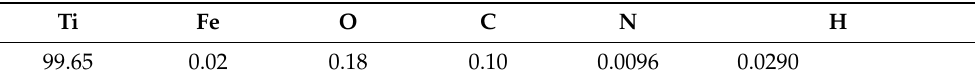
Table 1. Chemical composition of pure titanium grade II used in experiment [24,25].